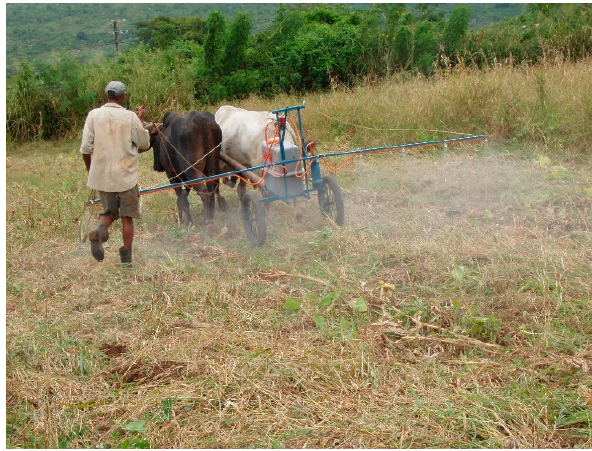
Figure 5. An animal-drawn sprayer for weed and cover crop management. The 80-L tank supplies a 5 m spray boom via a ground-wheel driven pump (Photo: B Sims).